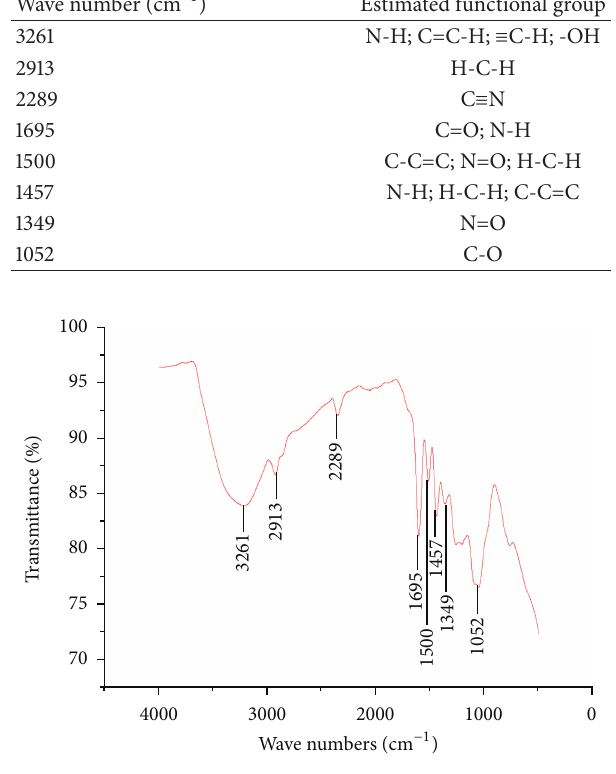
Figure 3: FTIR spectra of Myrmecodia Pendans